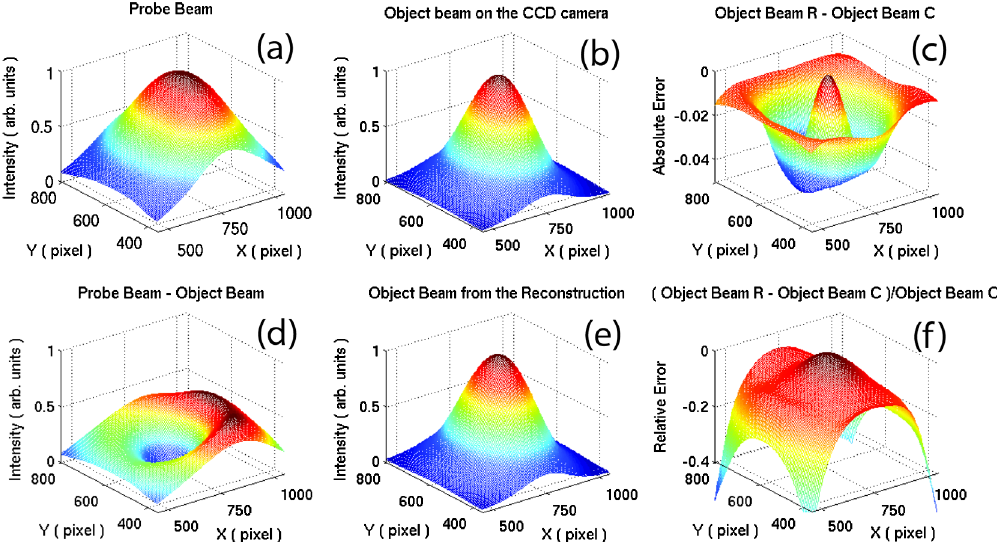
FIG. 7. The stacked soliton pulses intensity profile: (a) the normalized probe beam intensity; (b) the object beam intensity on the CCD camera; (c) the object beam intensity difference between retrieval process and the intensity on the CCD camera; (d) the probe beam intensity subtract from the object beam intensity; (e) the object beam intensity from retrieval process; (f) the relative error of the retrieval